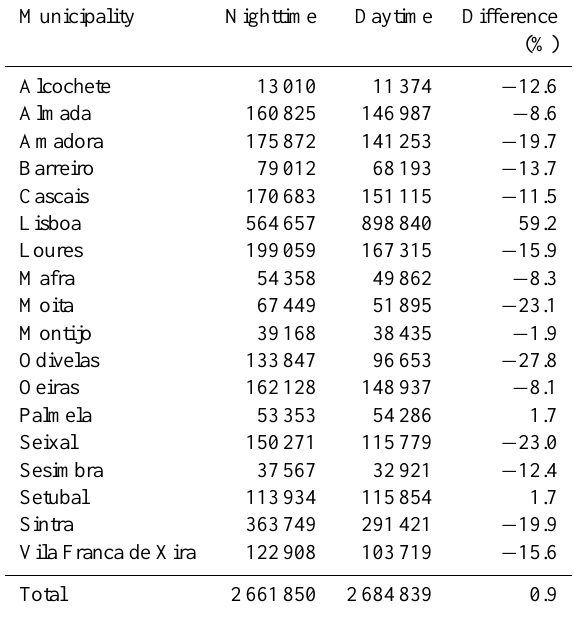
Table 1. Nighttime and daytime population in the municipalities of the Lisbon Metropolitan Area, in 2001 (derived from INE, 2001, 2003).